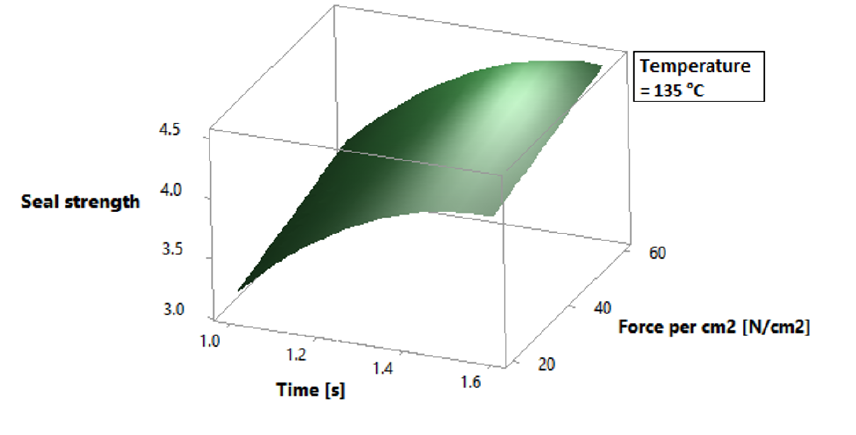
Figure 7 – Surface plot of Seal strength vs. Force per cm 2 and